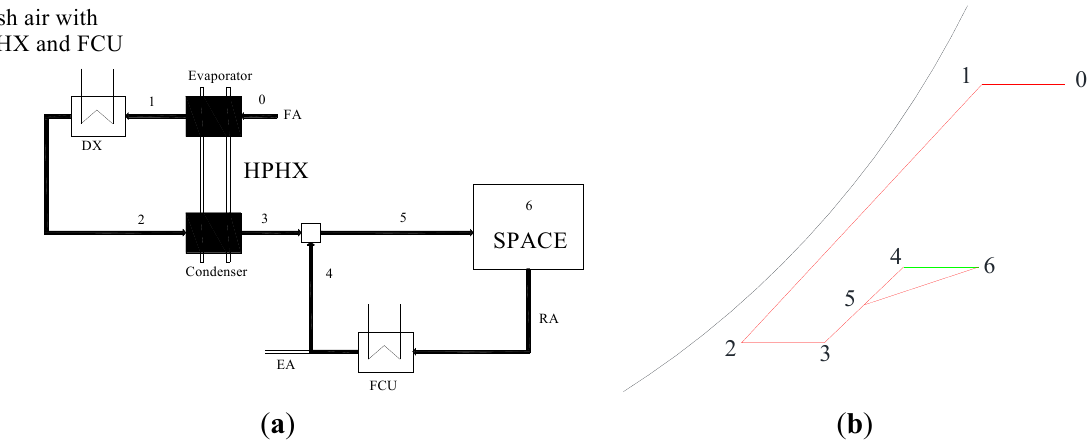
Figure 2. ( a ) The schematic diagram of the fresh air with HPHX and FCU; ( b ) The air treatment processes of the fresh air with HPHX and FCU system in a psychrometric